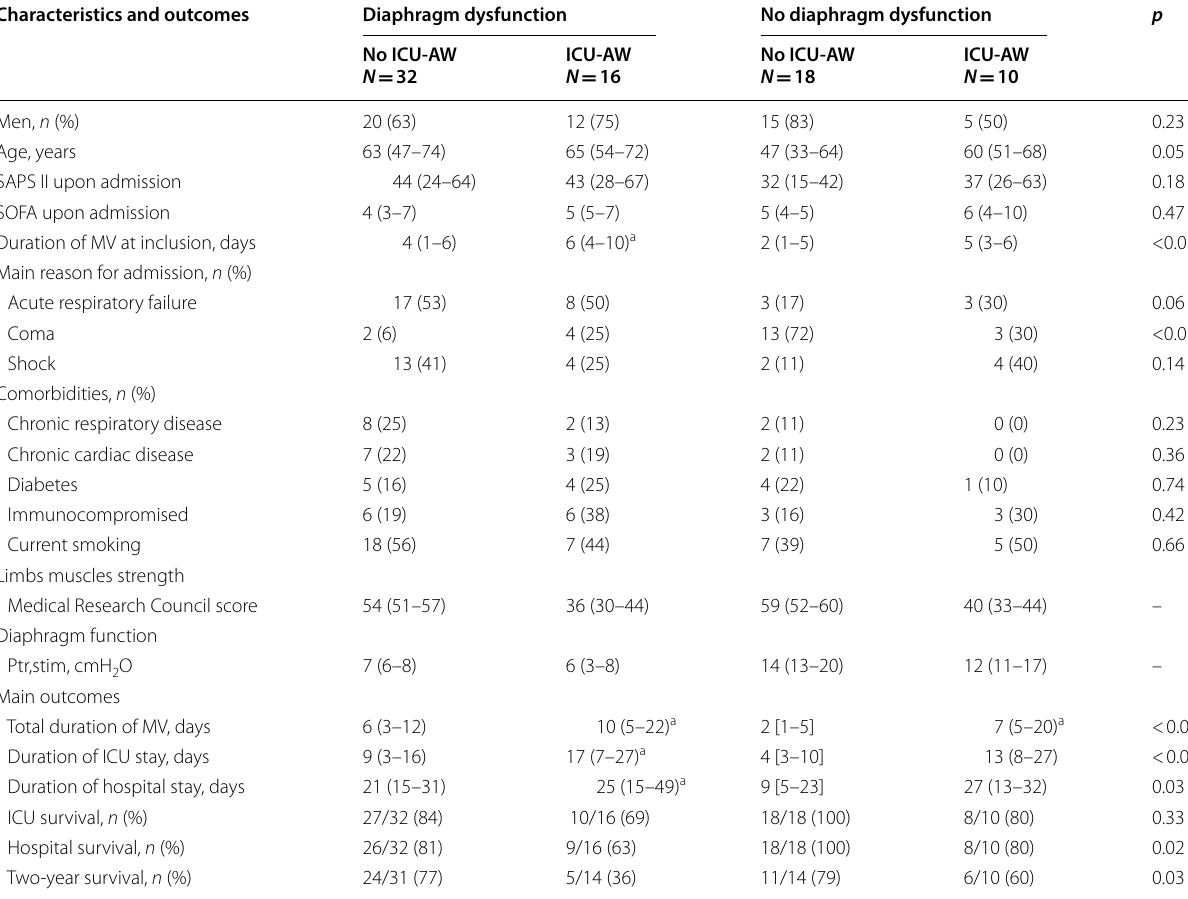
Table 1 Characteristics and main outcomes of the study’s population according to the presence of diaphragm dysfunction and intensive care unit-acquired weakness (ICU-AW) at time of liberation from mechanical